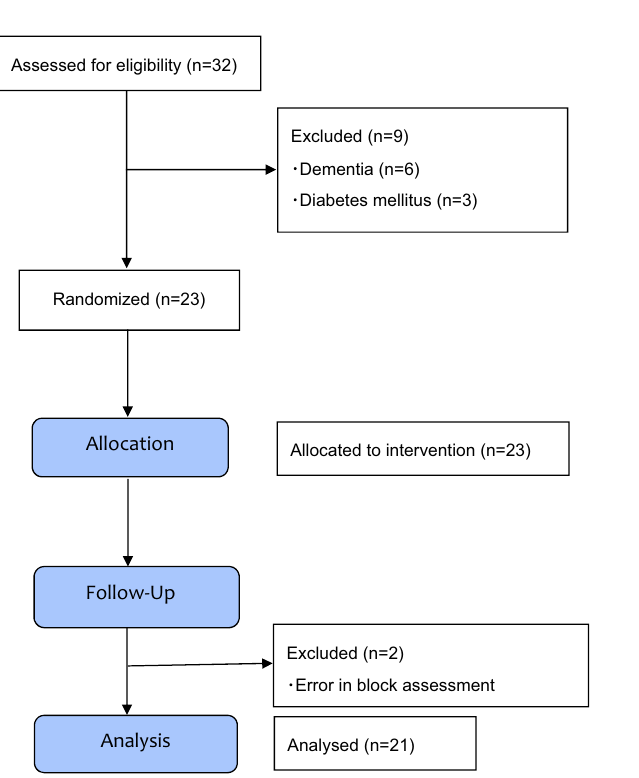
Figure 4. Consolidated standards of reporting trials (CONSORT) chart showing patient